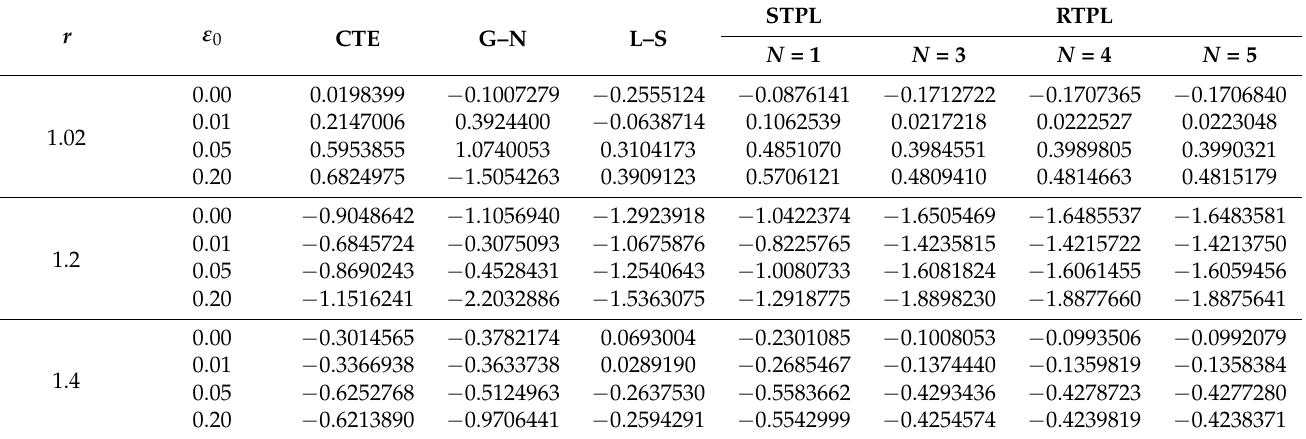
Table 15. Different thermoelasticity theories with a range of r values show the effects of dimensionless electric permittivity ε 0 on circumferential stress σ ΘΘ